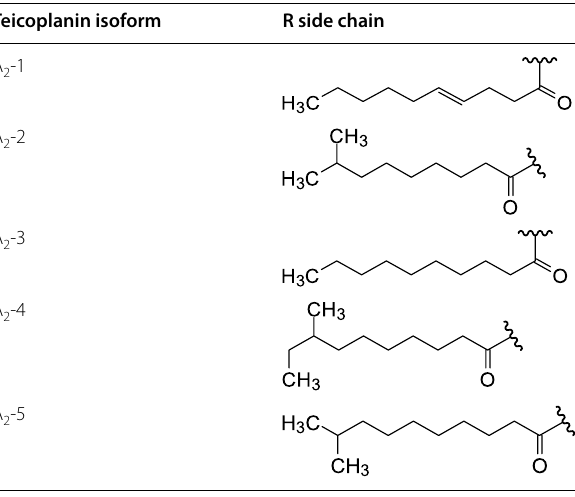
Table 3 Substitution patterns for the homologs of dalbavancin according to the nomenclature of reference [24, 25] Dalbavancin R